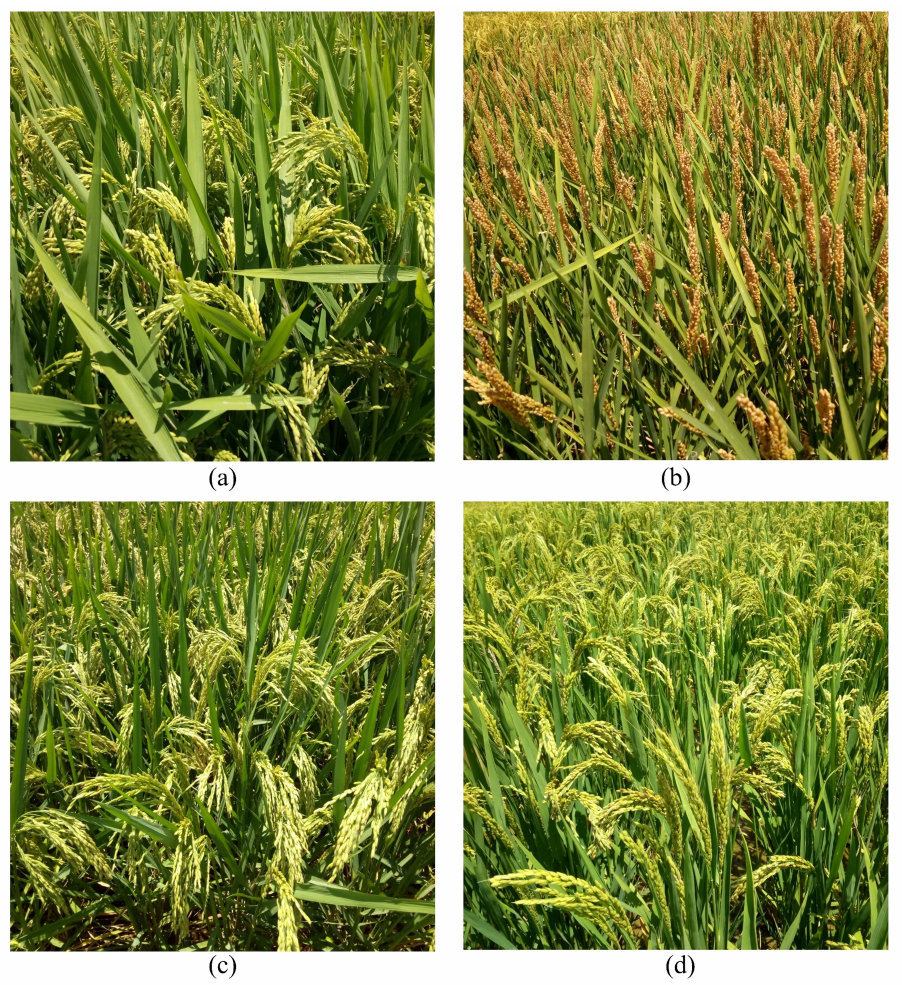
Figure 1. The field images of different rice varieties at heading stage: ( a ) Longyou-518; ( b ) Tianlong- 660; ( c ) Liangyou-1128; and ( d ) unnamed